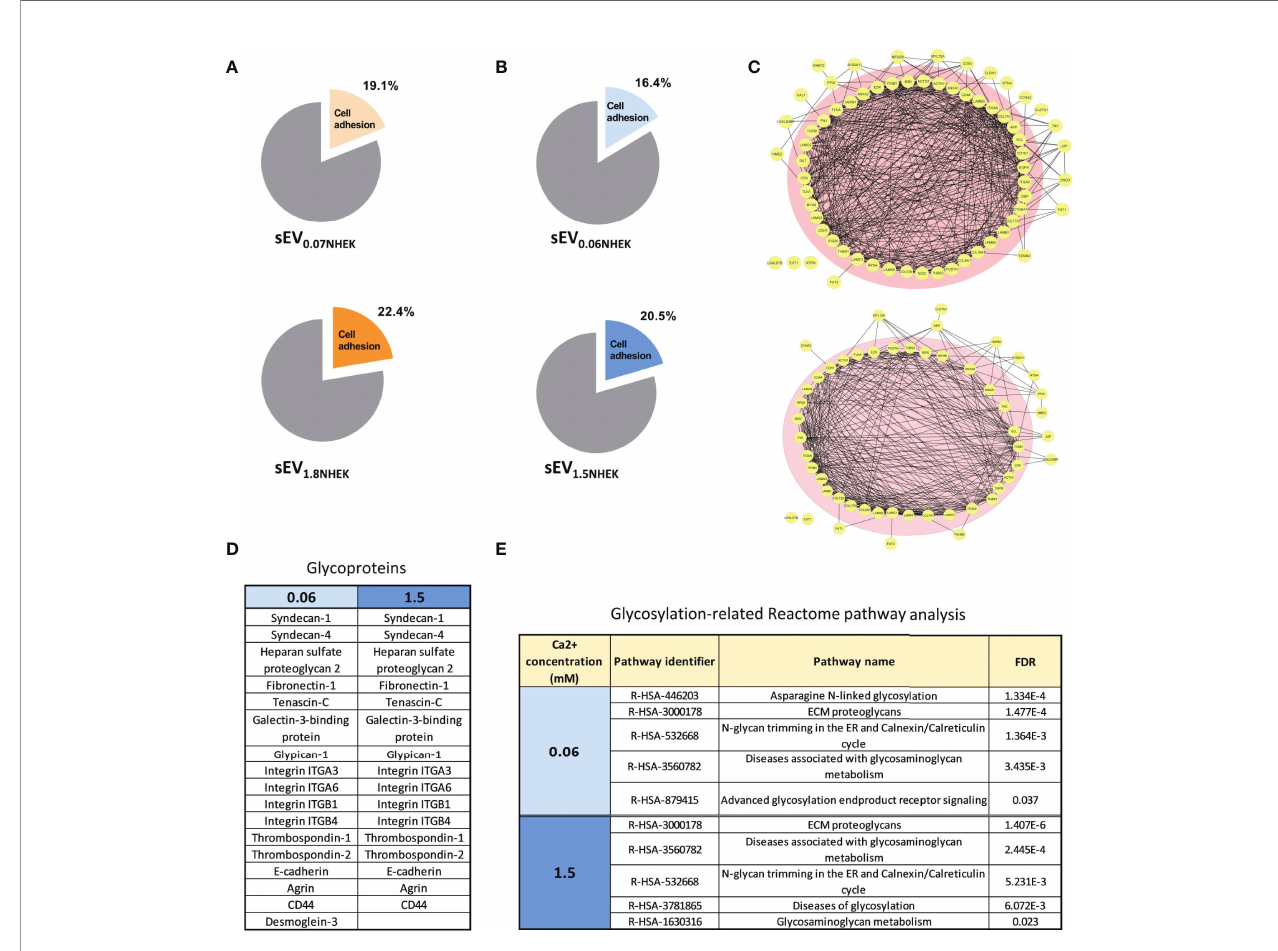
FIGURE 2 | Keratinocyte-derived sEVs are enriched in glycoproteinsinvolved inadhesion insteady state and inAD milieu. (A) Enrichment of adhesion proteins involved in cell adhesion in sEV NHEK secreted in steady-state keratinocytes; Reactome - Gene Ontology terms re-analysis of the data available from Chavez-Muñoz et al. (28); (B) enrichment of adhesion proteins involved in cell adhesion in sEV NHEK secreted by NHEKs exposed to AD milieu as identi fi ed by Reactome - Gene Ontology terms analysis; (C) interaction network for sEV adhesion-relevant proteins identi fi ed in sEV 0.06NHEK and sEV 1.5NHEK; (D) cell adhesion-relevant glycoproteins identi fi ed by mass spec in sEV 0.06NHEK and sEV 1.5NHEK; (E) Reactome-Gene Ontology identi fi ed term enrichment for the proteins in sEV 0.06NHEK and sEV 1.5NHEK ; FDR, False Discovery Rate; N.B. classical exosomal glycoprotein markers are included in the supplementary data ( Figure S2D ); mass spectrometry data based on n=3 biological